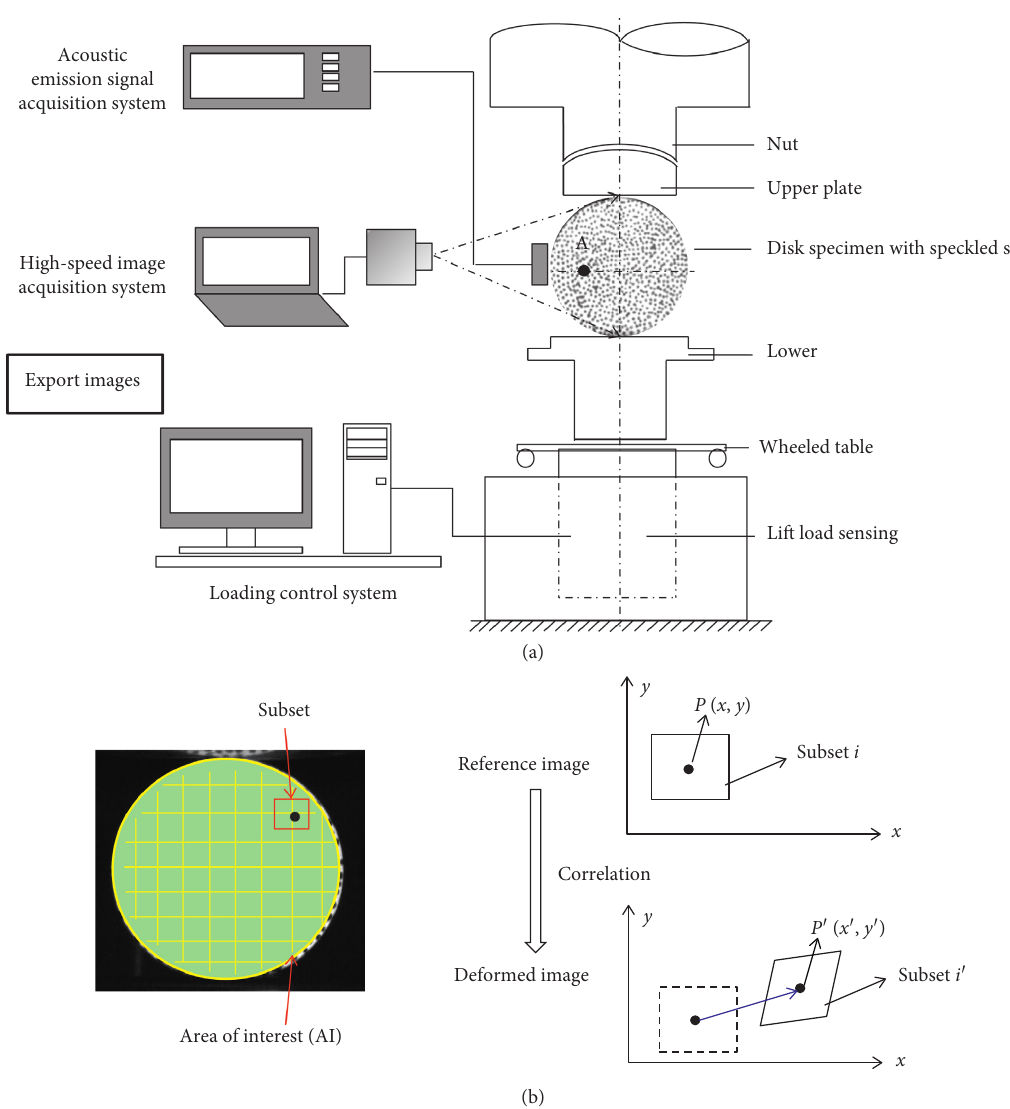
Figure 2: Schematic of (a) the Brazilian disk test experimental apparatus and the setup and (b) principle of